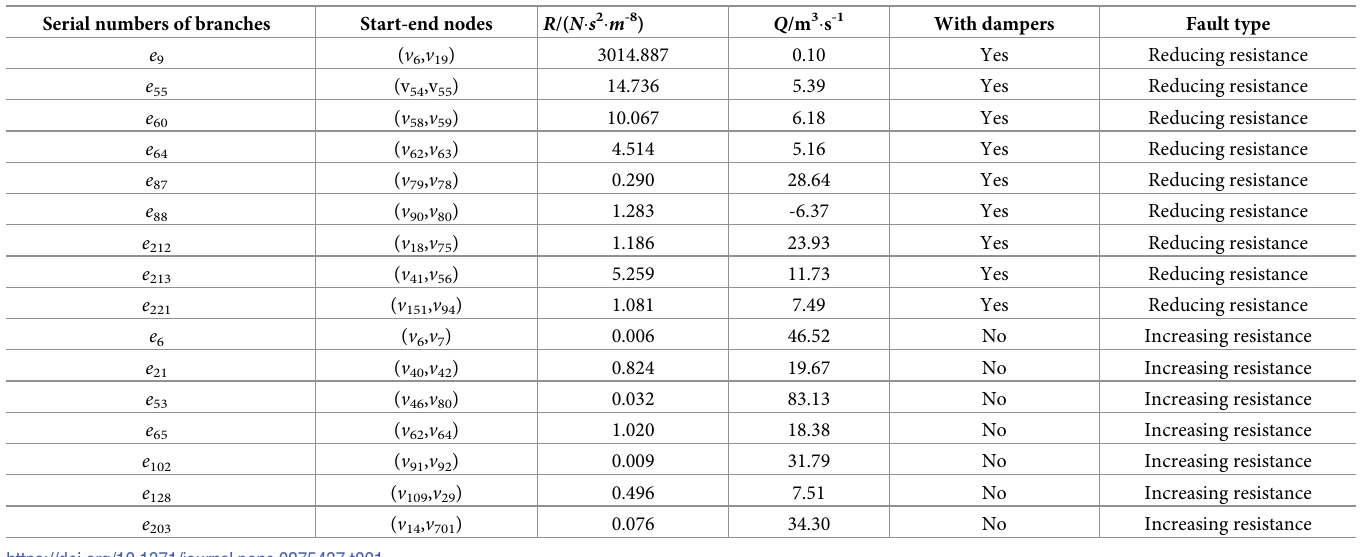
Table 1. Parameters of the fault test branches.